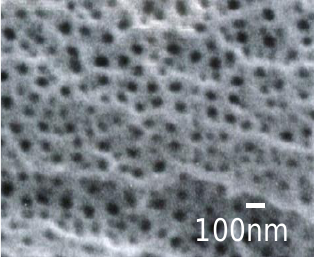
Figure 1. Nano-open structure of anodized-aluminum surface. Surface image was taken using a scanning electron microscope.